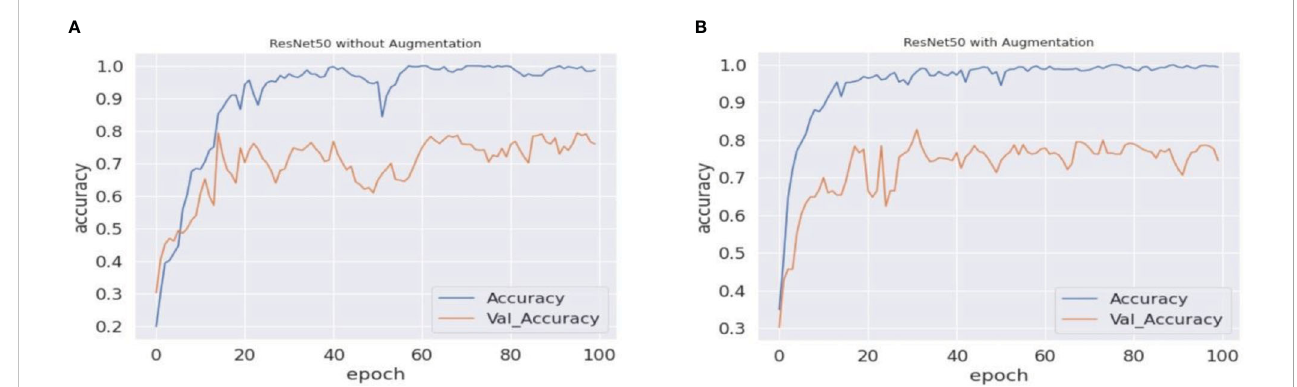
FIGURE 7 ResNet50 accuracy comparisons. (A, B) The graphical representation of validation and training accuracy results of the ResNet50 architecture on augmentation and nonaugmentation datasets for comparison. During the training process with the baseline dataset, the training curve reaches a saturation point after approximately 33 epochs, while the validation curve shows oscillation in the overall training process. In (B) , on the other hand, the training curve reaches a saturation point after approximately 30 epochs, while the validation curve regularly shows oscillation.